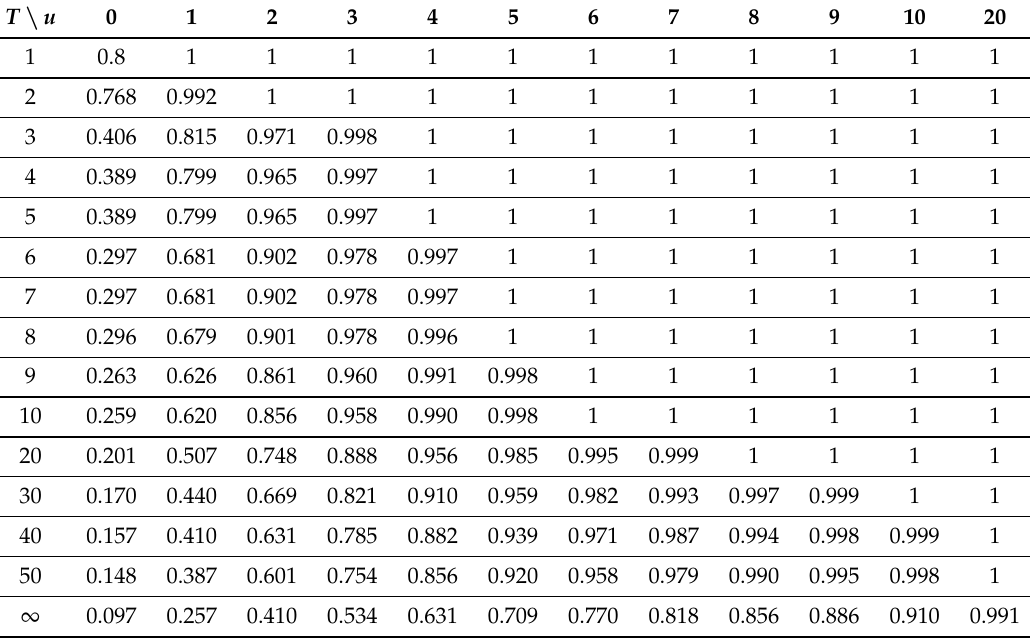
Table 10. Values of survival probabilities for the model described in Example 6.